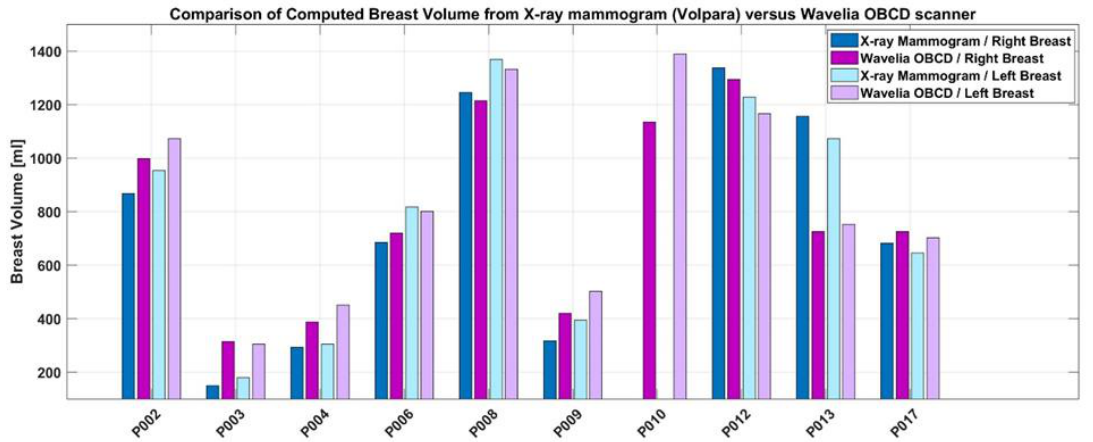
Figure 35. Comparative presentation of the breast volume, as computed by the Wavelia OBCD scanner (pendulous breast) and the X-ray mammogram (compressed breast - averaging over Cranio- Caudal and Medio-Lateral view